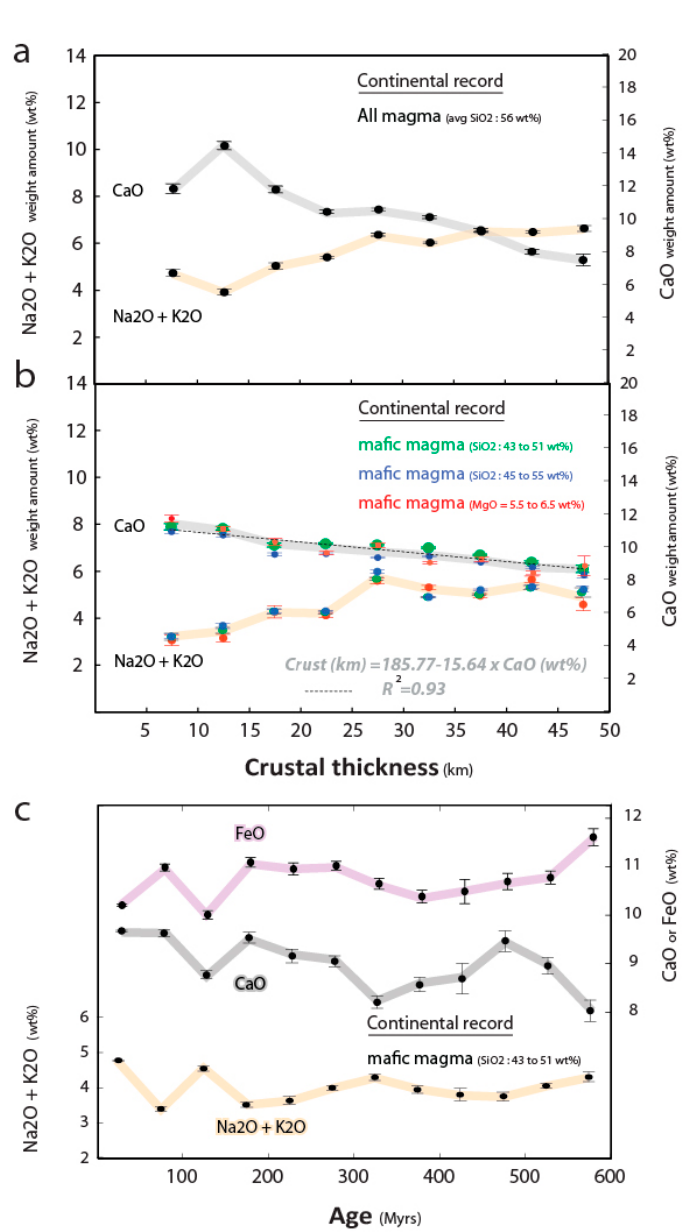
Figure 7. ( a ) Chemical composition of magmas plotted against crustal thickness [9] where young Cenozoic magmas (ca 10–0 Ma) were emplaced (lava, continental s.l. record). The Ca content of magma decreases with increasing alkali content (Na + K) and crustal thickness. Ca-rich magmas dominantly developed in the thinnest crustal sections (<25 km), marked by a strong anti-correlation between Ca and the alkali elements (Na + K). A less marked anti-correlation is observed in the thickest crustal sections (>25 Km). Beyond 45 km, less confidence can be given to the bootstrapped values, due to the lack of data in the geological record. ( b ) Whatever the range of composition considered for mafic magma (Si 43–51 ; Si 45–55 or Mg 06 ), the slope of correlation (black dotted line) between crustal thickness and Ca in mafic magma appear broadly similar. R 2 corresponds to the coefficient of determination associated with the line. ( c ) Statistical assessment of the evolution of mafic magmas (43 < SiO 2 < 51 wt%) in FeO T , CaO and Na 2 O + K 2 O wt% through time (black drawbars; uncertainty bars correspond to ±1 σ standard deviation for age step of 50 Myrs). It confirms the anti-correlation between Ca (grey curve) and alkali-elements (orange curve) in magma and, to some extent with the iron (Fe) content (mauve